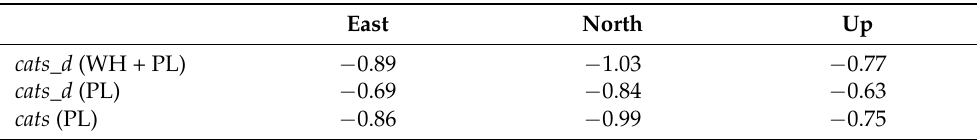
Table 3. PL noise mean spectral index for the each of the two CATS-estimated solutions with or without WH noise estimation along PL